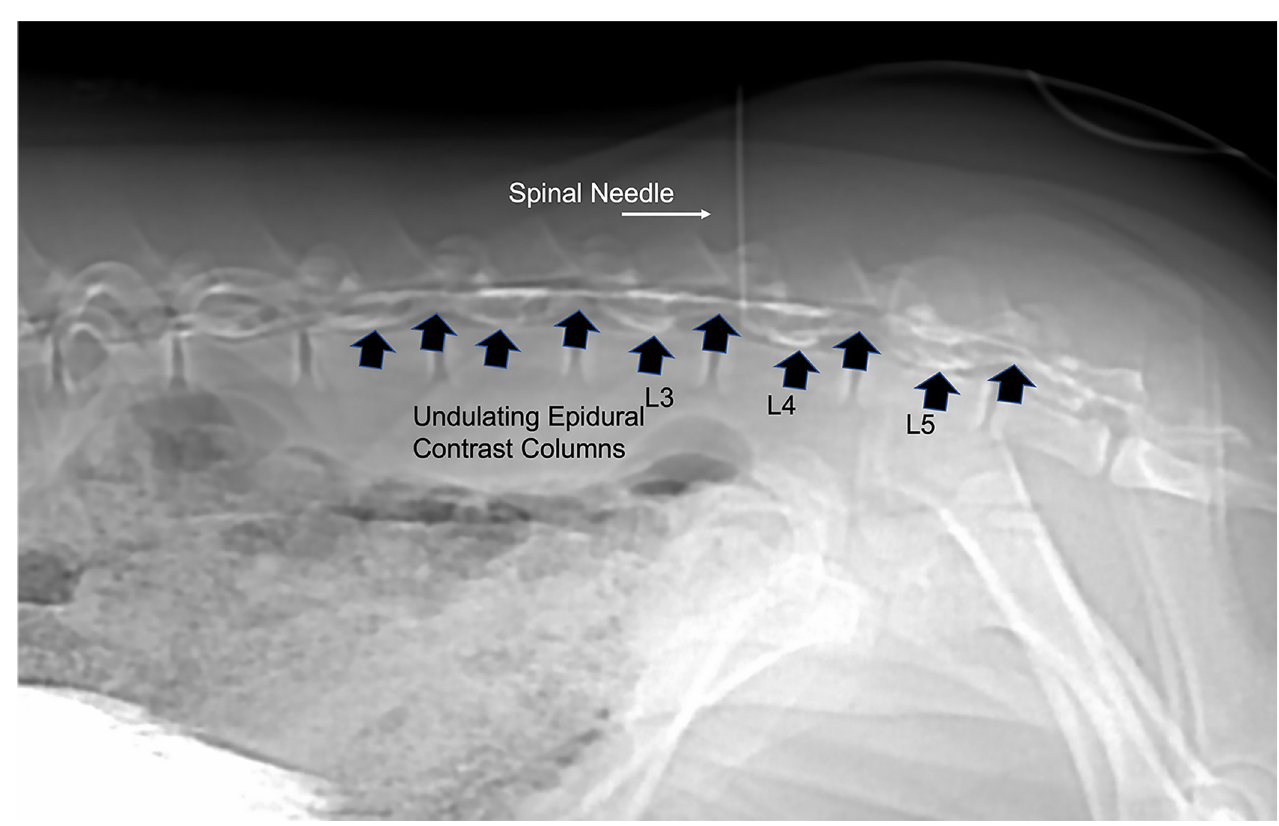
Fig 3. Sagittal scout showing epidural extravasation of contrast medium. This occurred in one pig and the needle was removed and a new spinal needle was placed a second time and a second test injection was performed and showed linear contrast columns of the subarachnoid space.